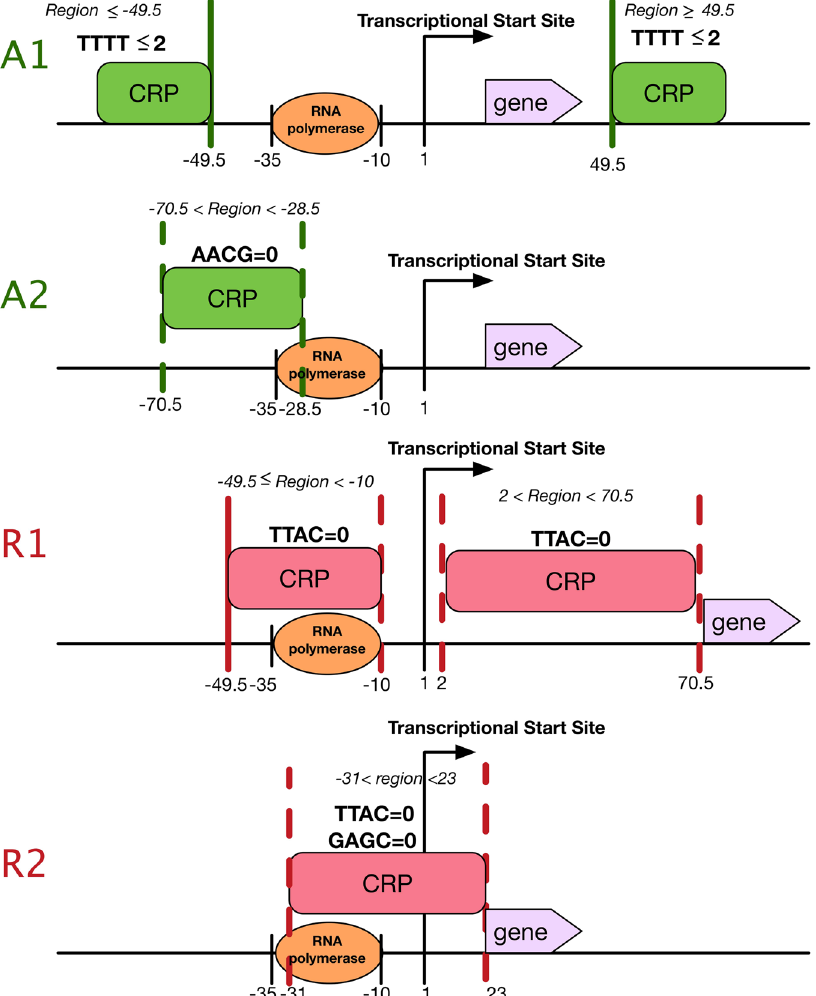
Figure 3. Four interpretable rules for illustrating the regulatory roles of CRP acting on the binding